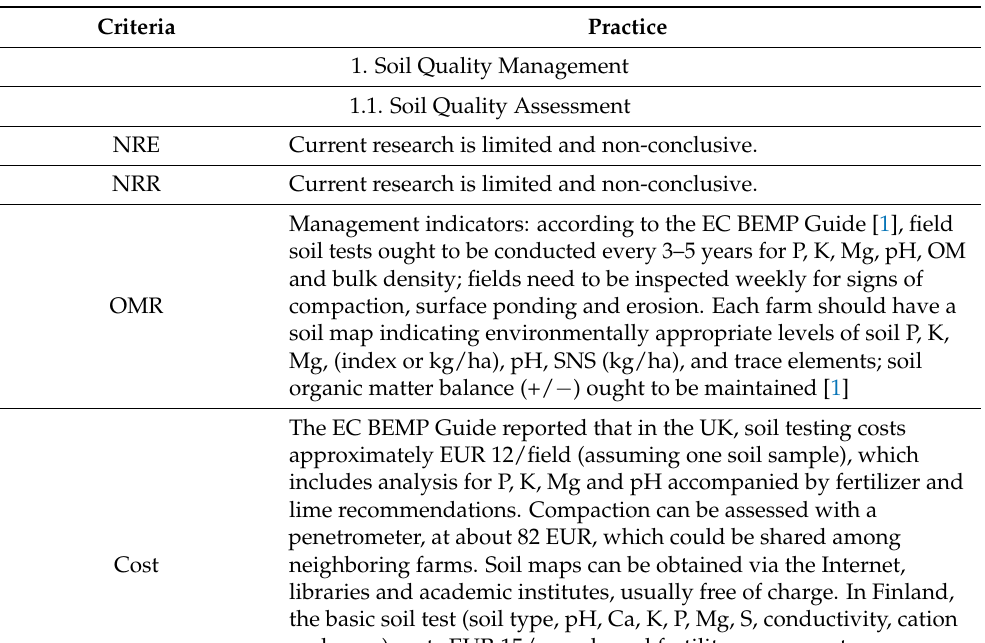
Table 4. Good Agricultural Practices—nutrient reduction efficiencies (NRE), potential for nutrient recycling and recovery (NRR) and operation and maintenance requirements (OMR) and